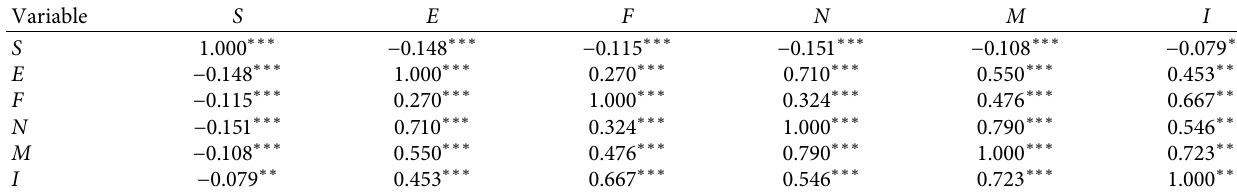
Table 6: QAP correlation analysis between influencing factors matrices.